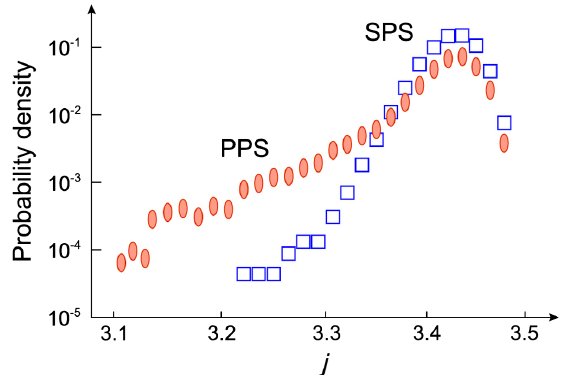
FIG. 3. Probability densities of SPS and PPS as functions of normalized current in solenoid. Blue squares correspond to SPS; red ovals correspond to PPS transitions. These measurements have been performed at T ¼ 60